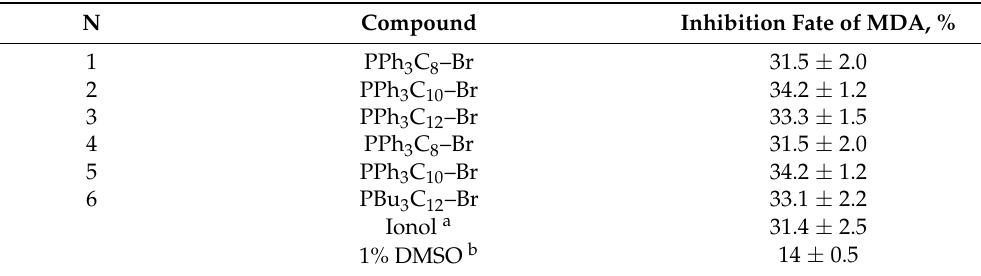
Table 4. Antioxidant activity of PILs ( n =